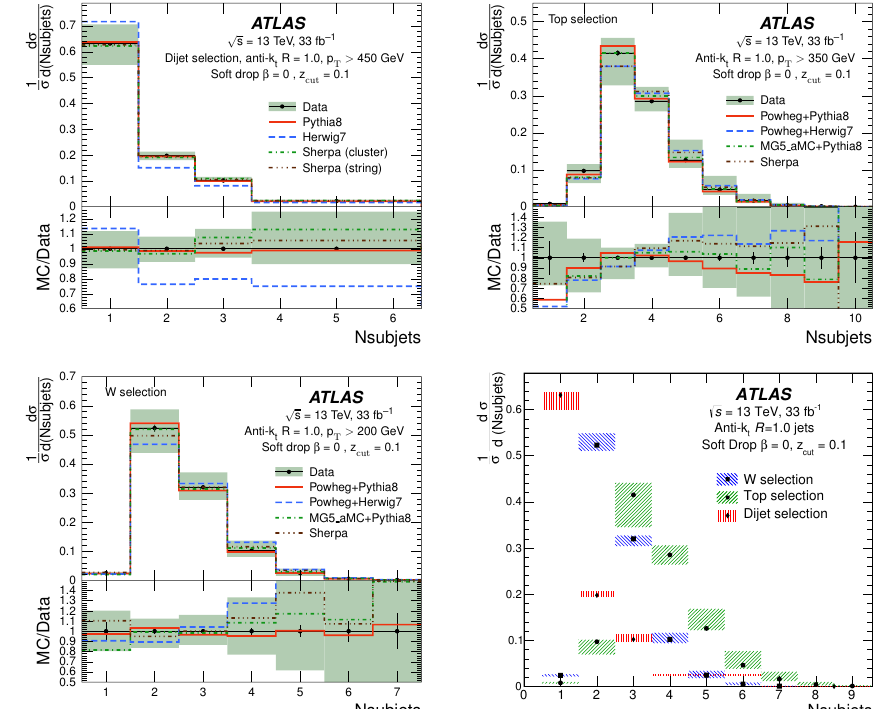
Figure 3 . Subjet multiplicity distributions compared with different MC predictions for soft- dropped large-radius jets from dijet (top left), top (top right), and W (bottom left) selections. For the dijet selection, Sherpa is tested with two different hadronisation models. Data are com- pared between the soft-dropped large-radius jets for the three selections mentioned above (bottom right). The shaded bands represent the total uncertainty, while the error bars show the statistical uncertainty, except in the bottom right plot, where the shaded areas represent the total